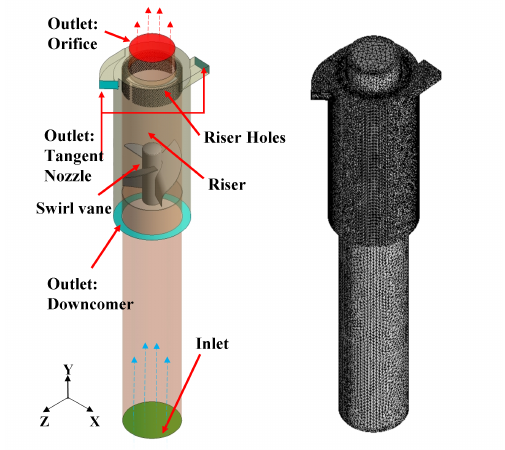
Figure 1. Schematic of the computational domain and the mesh